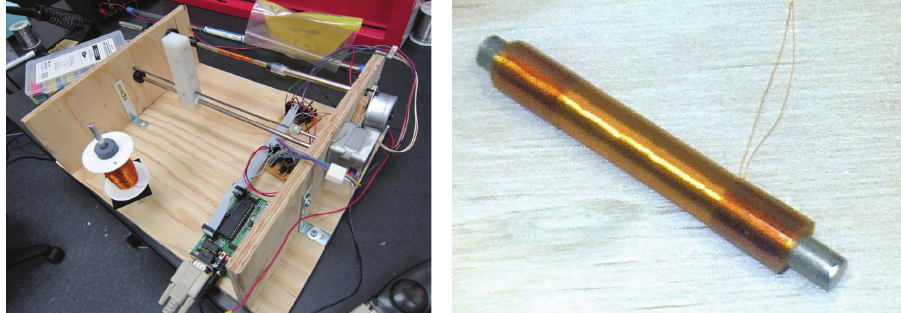
Figure 4: Magnetorquer winding apparatus and completed torque rod.